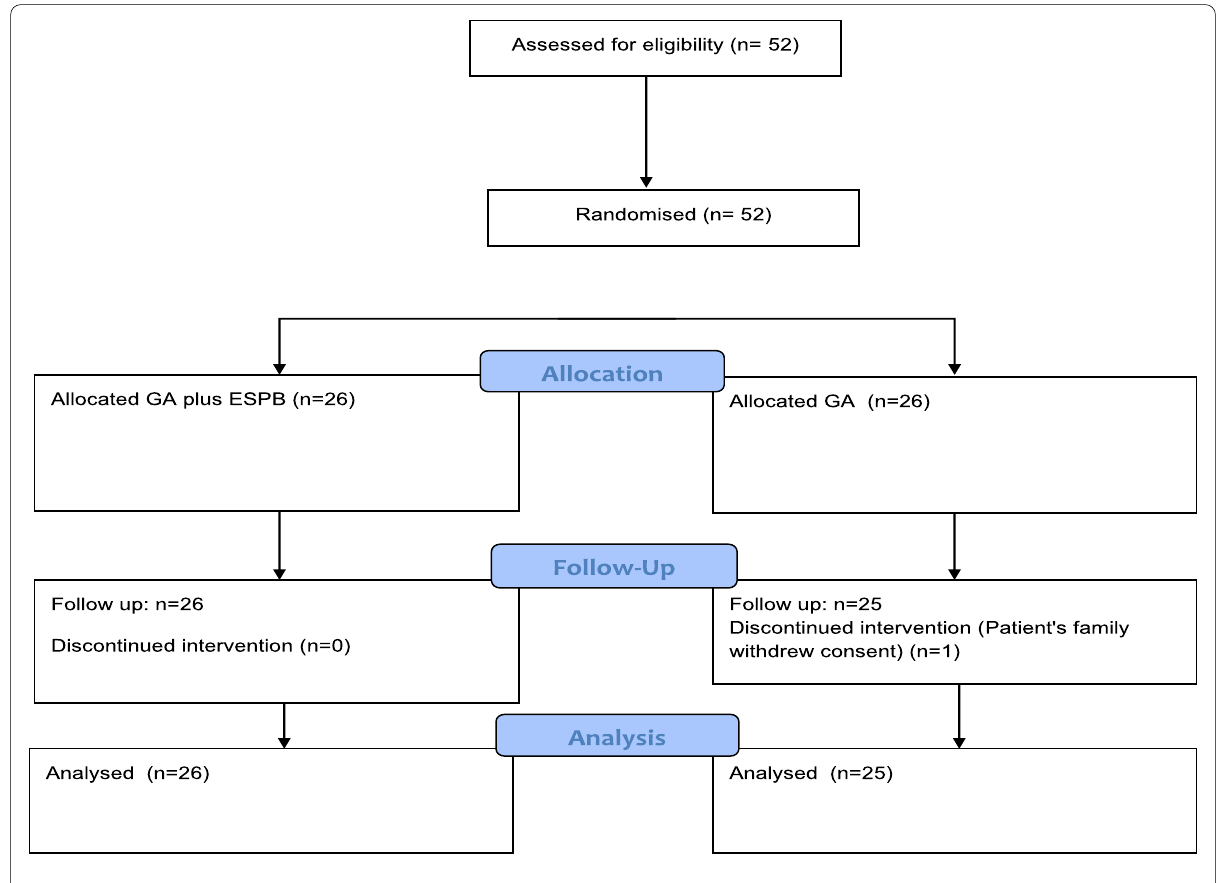
Fig. 2 CONSORT diagram of participants’ recruitment. GA: general anesthesia, ESPB: erector spinae plane